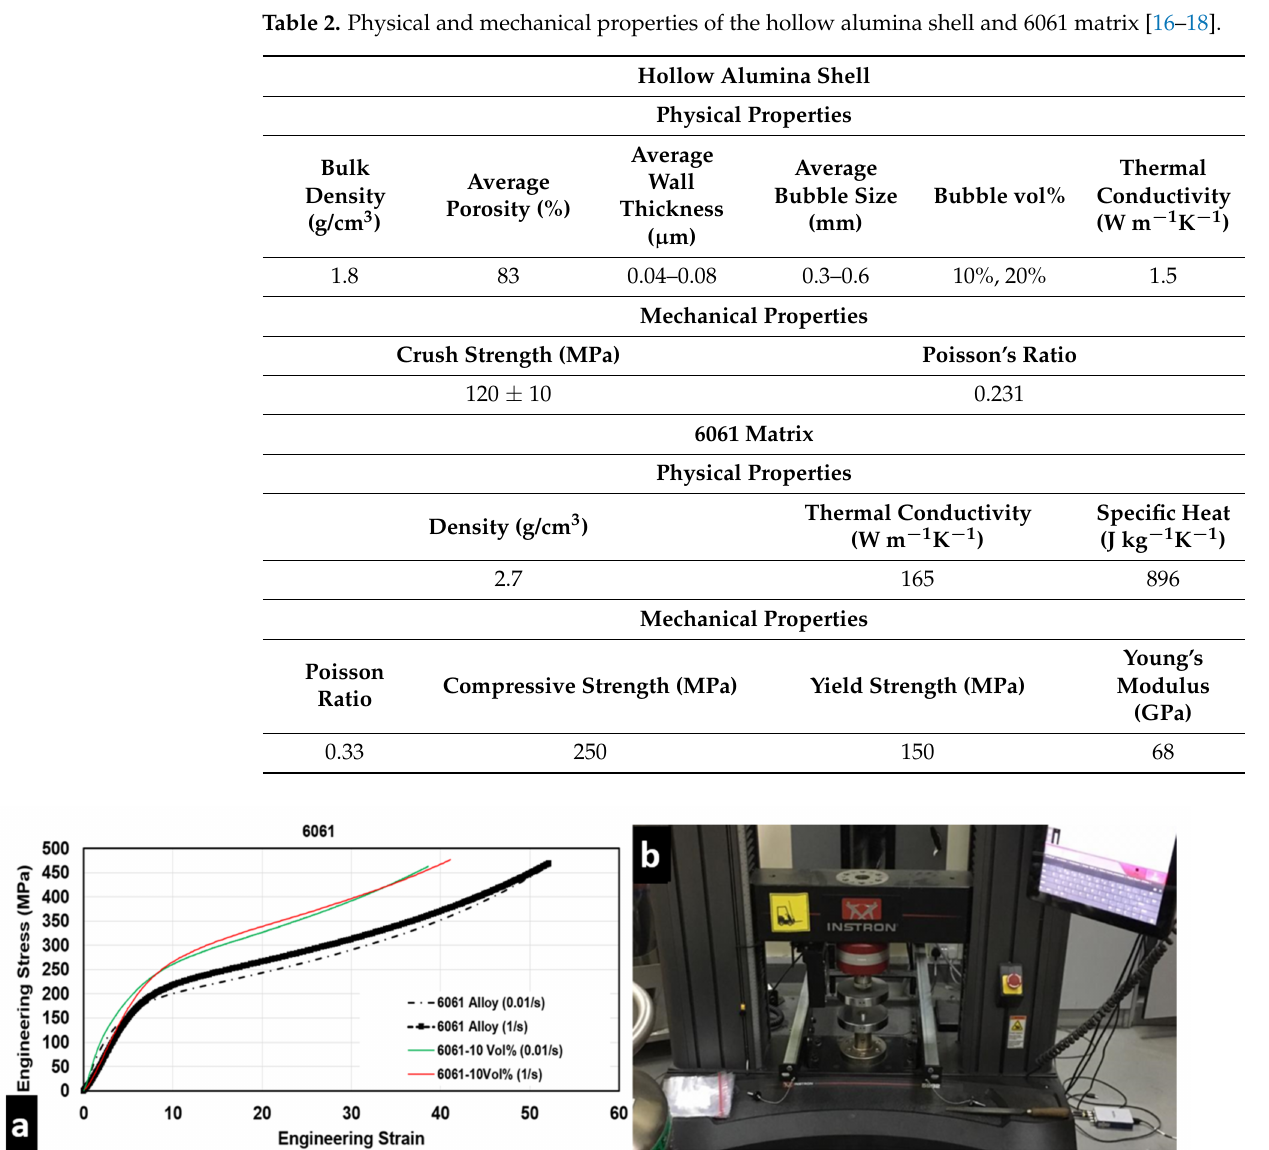
Figure 2. ( a ) Stress–strain compression behavior of the 6061 aluminum syntactic foam and ( b ) compres- sion test